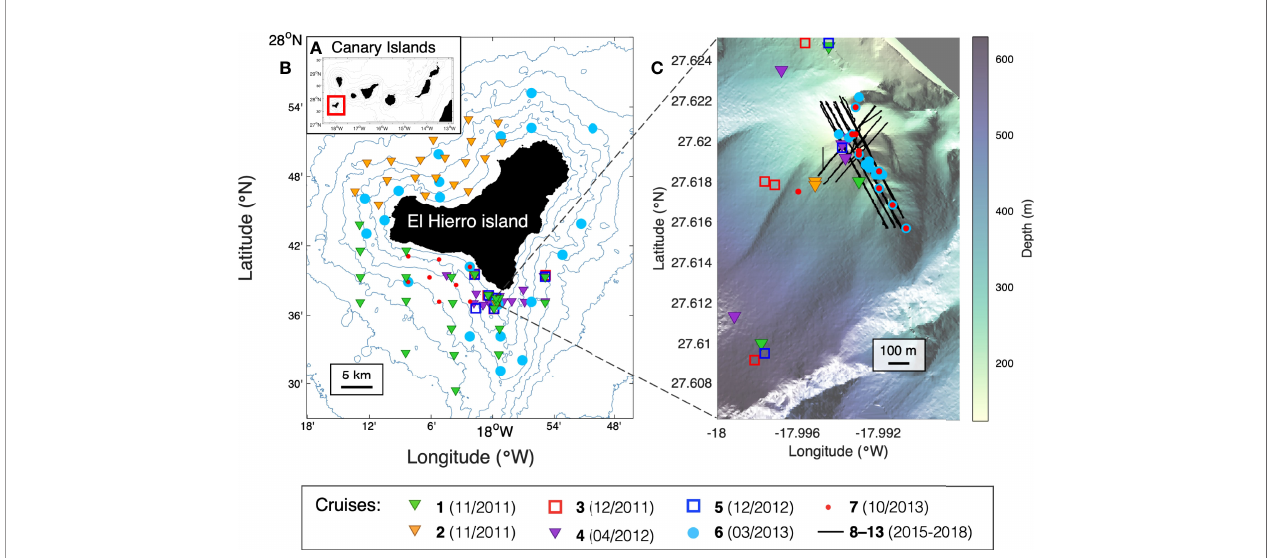
FIGURE 1 | Study location. (A) Map of the Canary Islands. (B) Map of El Hierro island with the location of the vertical pro fi les carried out during all cruises. (C) 3D- High-resolution bathymetry of Tagoro submarine volcano, indicating the location of the hydrographic stations (cruises 1 – 7) and tow-yo transects (cruises 8 –